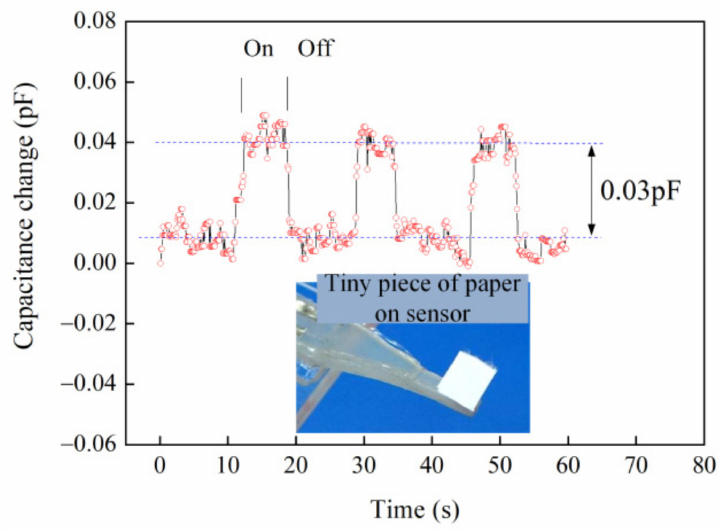
Figure 13. Capacitance change with time for placing on and off a tiny piece of paper (2 mgf). To compare with the flexible capacitive and resistive pressure sensors in the literatures, the sensitivity of the No.1 sensor was discussed for pressure measurement. According to the performances test of force sensing in Section 3.3.1, the fitting relationship between the capacitance change ( ∆ C ) and the force ( F ) was ∆ C = 1.660 F . The relative capacitance change was defined as ∆ C / C 0 . The initial capacitance ( C 0 ) of the No.1 sensor is 51.44 pF. Based on this, the fitting relationship between the relative capacitance change and force was ∆ C / C 0 = 0.0323 F . The force ( F ) in the above equation can be converted into pressure ( P ), that is equal to F divided by the area of the PET plate (3 mm 2 × 3 mm 2 ) fixed to the free end of the beam. Hence, the relationship between the relative capacitance change and the pressure was ∆ C / C 0 = 0.290 P . The sensitivity of No.1 sensor was 0.290 kPa − 1 for pressure measurement. These results make our tactile sensor more sensitive than some flexible capacitive and resistive pressure sensors, as shown in Table